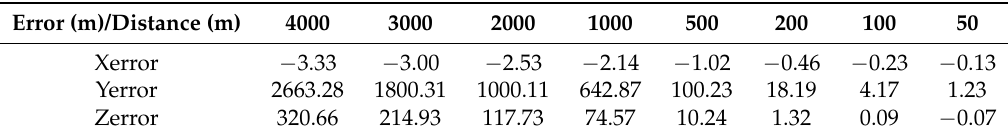
Table 2. Errors when the center extraction of the aircraft with 5-pixel disturbance, f = 100 mm and D = 10